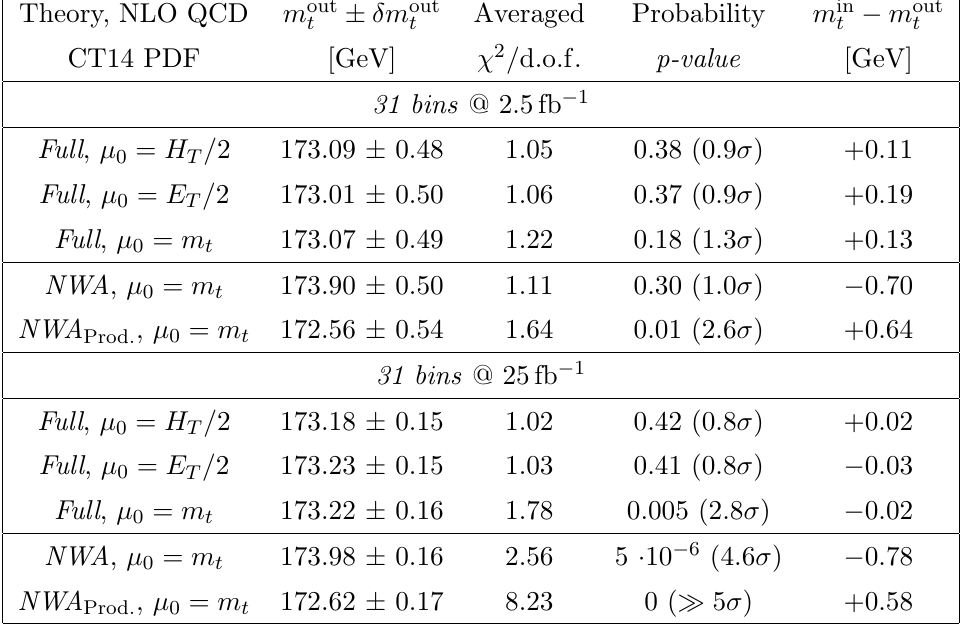
Table 7 . Mean value of the top quark mass, m out , from 1000 pseudo-experiments as obtained from t the normalised M b‘ di(cid:11)erential distribution for the pp e + (cid:23) e (cid:22) (cid:0) (cid:22) (cid:23) (cid:22) b (cid:22) bj + X production process at ! the LHC with p s = 13 TeV. Also shown is 68 % C.L. (1 (cid:27) ) statistical error of the top quark mass, (cid:14)m out , together with the averaged minimal (cid:31) 2 =d:o:f and the p-value. The number of standard t deviations corresponding to each p-value is presented in parentheses. In the last column the top quark mass shift, de(cid:12)ned as m in m out , with m in = 173.2 GeV, is also given. Luminosity of 2.5 fb (cid:0) 1 t (cid:0) t t and 25 fb (cid:0) 1 is